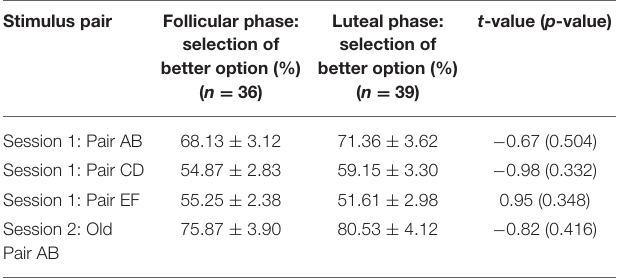
TABLE 2 | Learning performance did not differ between the follicular and luteal phase.